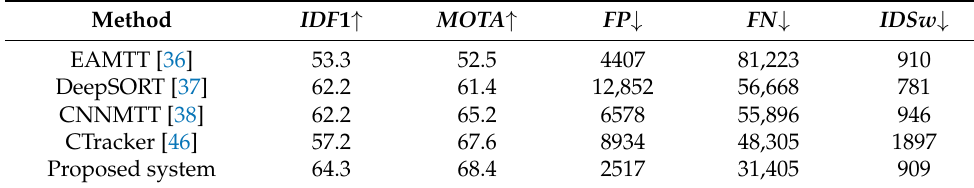
Table 3. Results of private detectors on MOT16 dataset (Offline Methods).